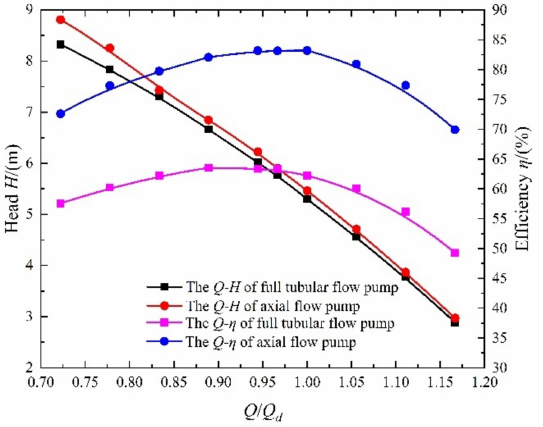
Figure 9. The performance curve of the axial flow pump and the full tubular pump.